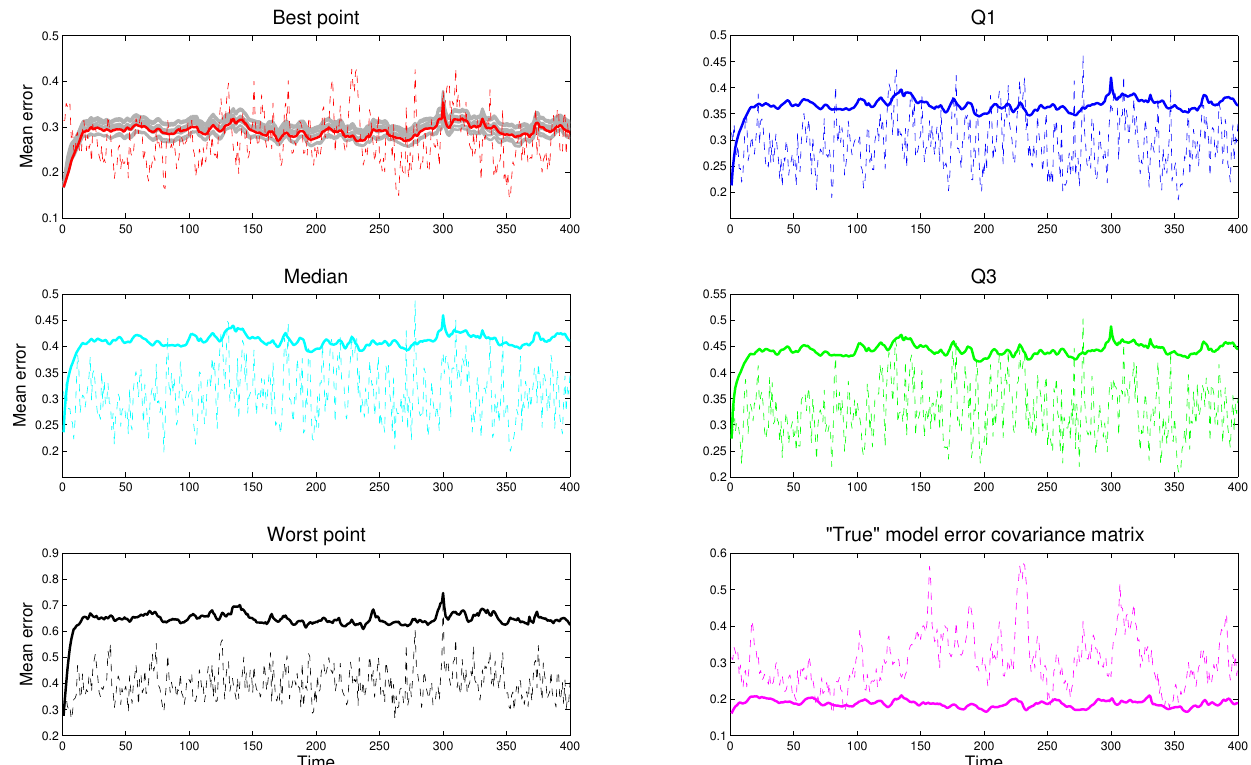
Figure 6: The true forecast error vs. the Kalman filter forecast error calculated using different parameter combinations, and the “true” model error covariance matrix obtained from samples of model error. Dashed lines indicate the true RMS forecast error and solid lines the squared mean variance of the forecast error covariance matrix. In the first subplot, the latter metric is also calculated from points that give the ten lowest cost function values (grey lines). The subplots Q1, median and Q3 give the results for parameter values that correspond to the three quartiles of the cost function values. Note the difference in scales on each subplot.